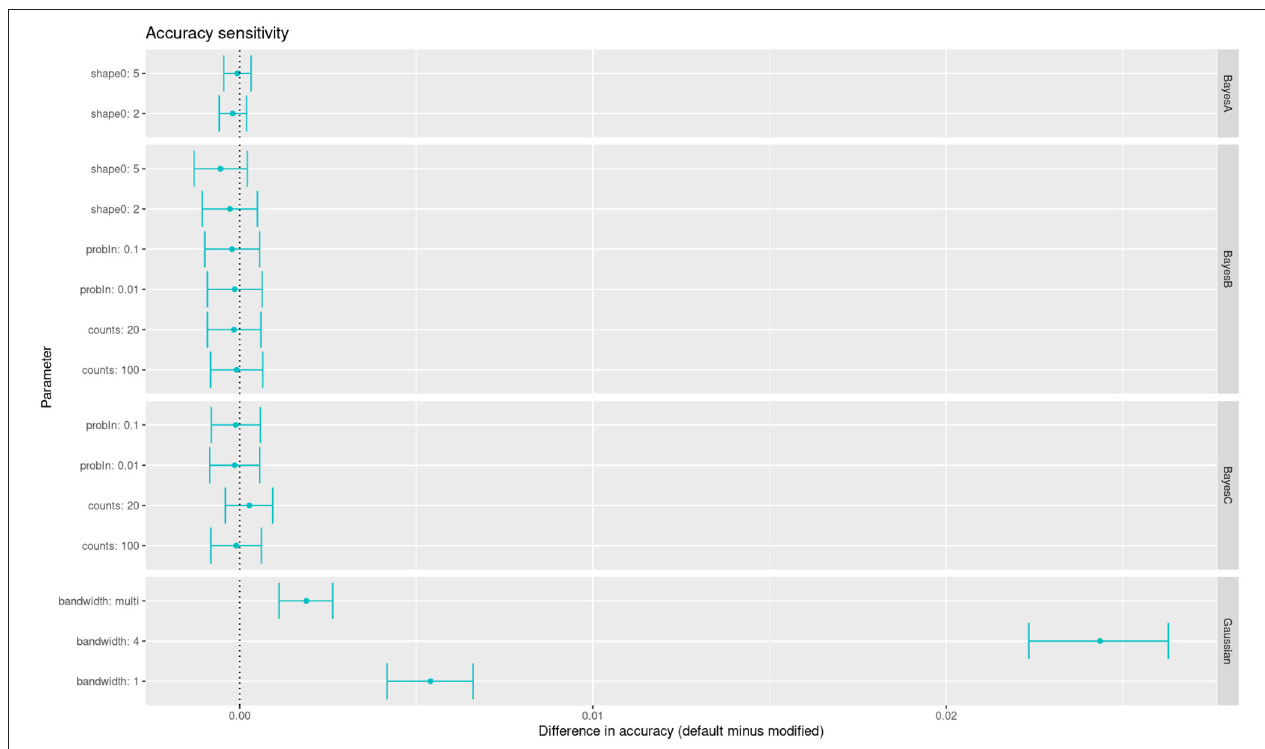
FIGURE 4 | Accuracy sensitivity of multiple models to changes in the values of their hyper-parameters (alternative values compared with respect to defaults in BGLR software).